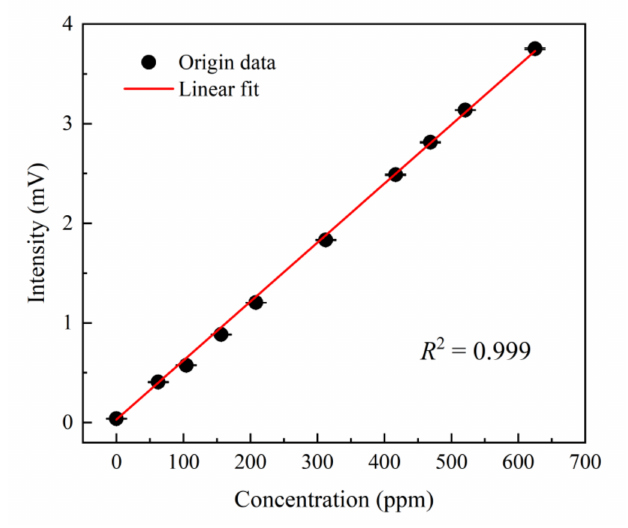
Figure 5. Relationship between the chloroform concentration and the measured signal intensity. Ten different concentrations of chloroform gas were measured in the experiment.